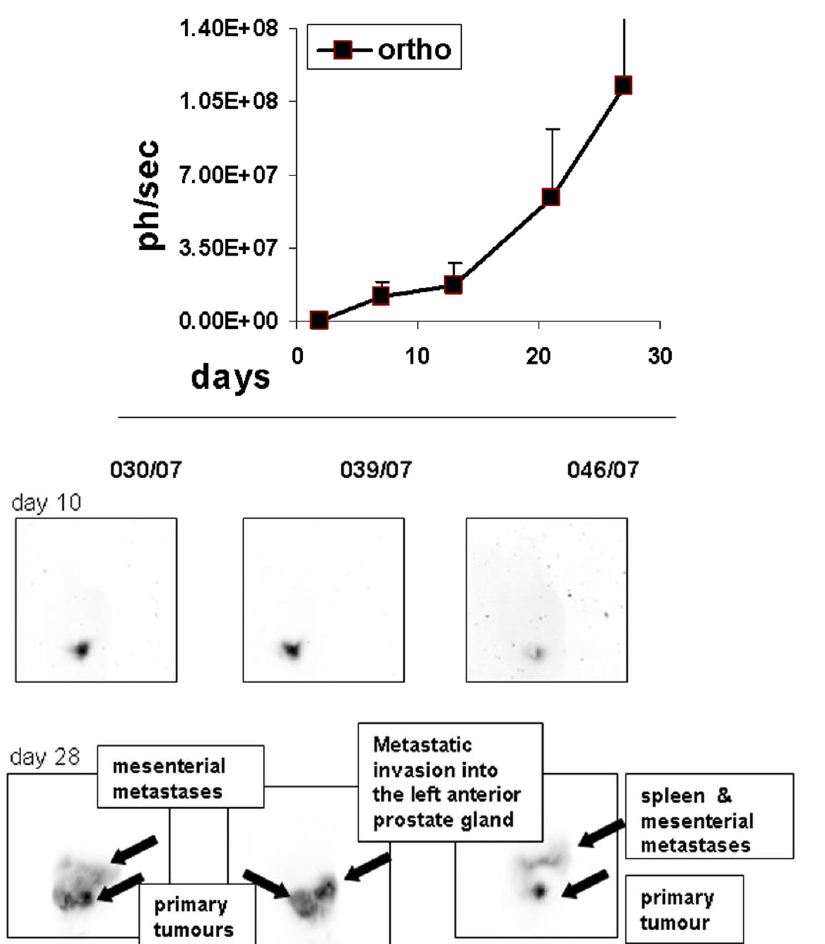
Figure 3. Growth curve of orthotopic MAT-Lu PCa determined by luciferase in vivo imaging and tumor images from orthotopic MAT-Lu PCa. (Above) Tumor growth follow up by in vivo bioluminescence image-analysis once a week in a Nightowl LB981 camera system (Berthold, Bad-Wildbach, Germany). Growth was terminated at day 27 due to general health situation. (Below) Inverted images of in vivo bioluminescence from three individual rats at different imaging time points (days 10 and